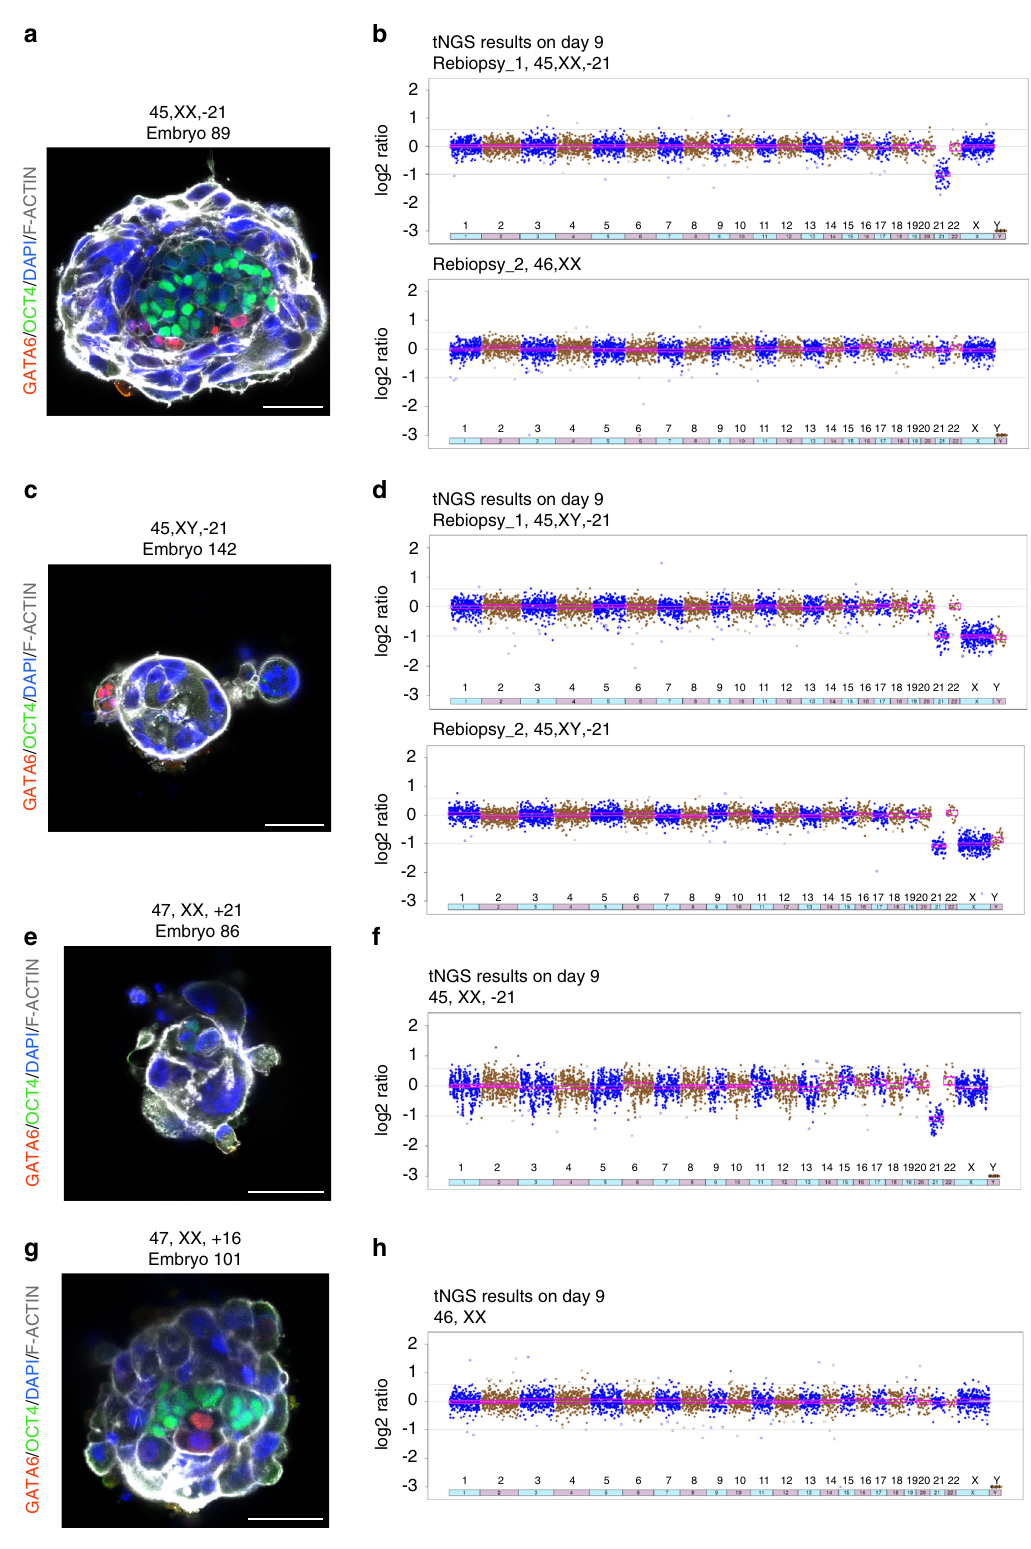
mosaic mouse and human embryos 19,26,27 . These results are also in agreement with observations indicating that trisomic embryos can give rise to trisomic human embryonic stem cells (ESCs), whereas euploid human ESCs can be obtained from monosomic embryos due to mosaicism 28,29 . Embryo 142, which was diag- nosed as 45,XX, − 21 based on trophoblast biopsy at day 5